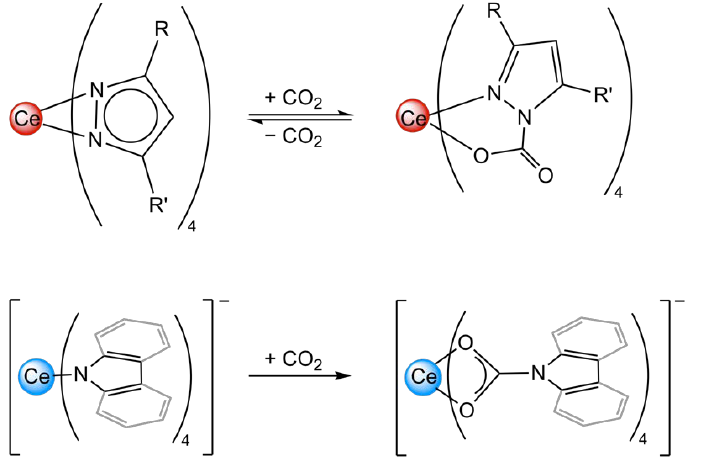
Scheme 3. Reversible and irreversible CO 2 insertion into Ce − N(pz) and Ce − N(pyr)/Ce − N(cbz) Sch3 bonds,